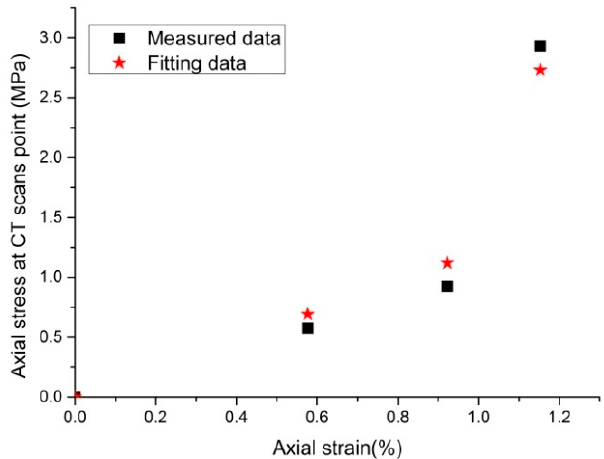
Figure 12. Comparison of the measured data and fitting data. The fitting results were obtained from the damage constitutive equation.